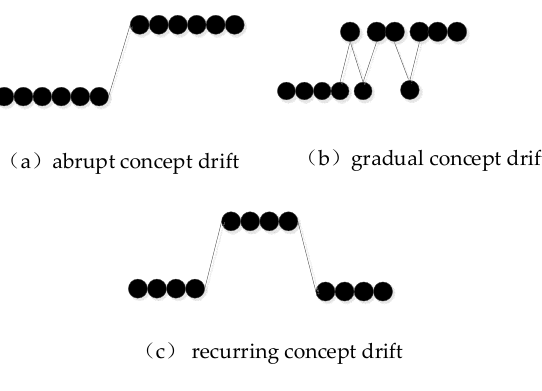
Figure 1. Types of concept drift